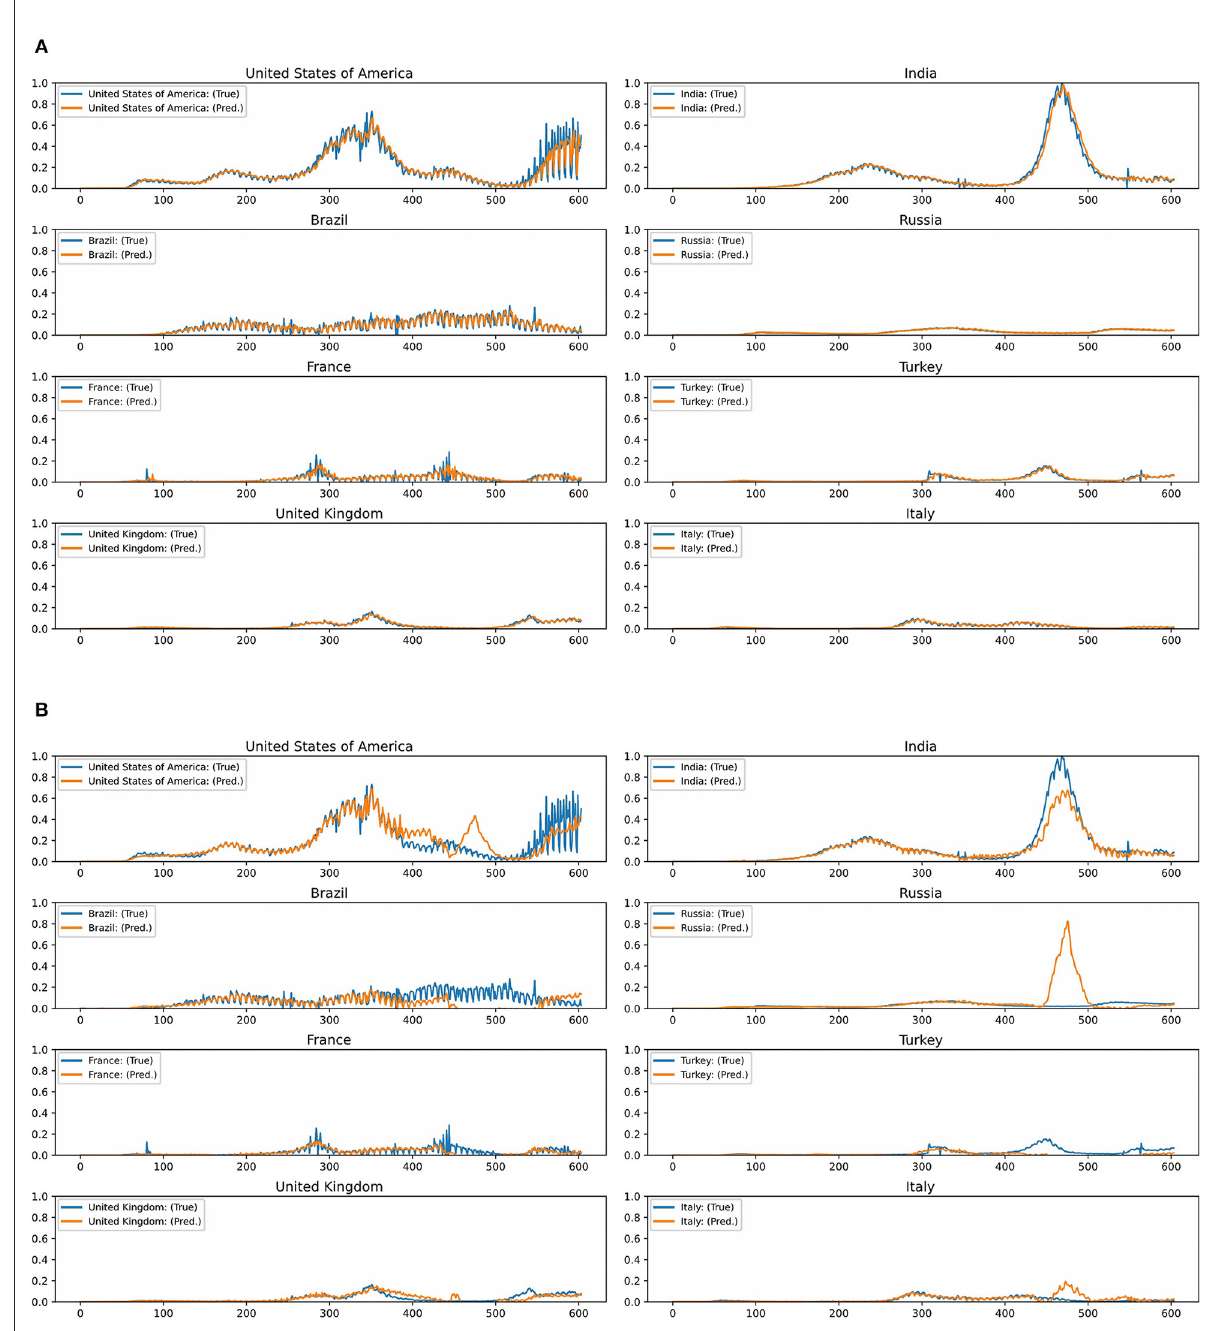
FIGURE2 (A) Test predictions and ground truth values for the graph convolutional network model with the airway adjacency matrix in the top eight countries with the highest number of new infections. (B) Test predictions and ground truth values for the multilayer perceptron model in the top eight countries with the highest number of new